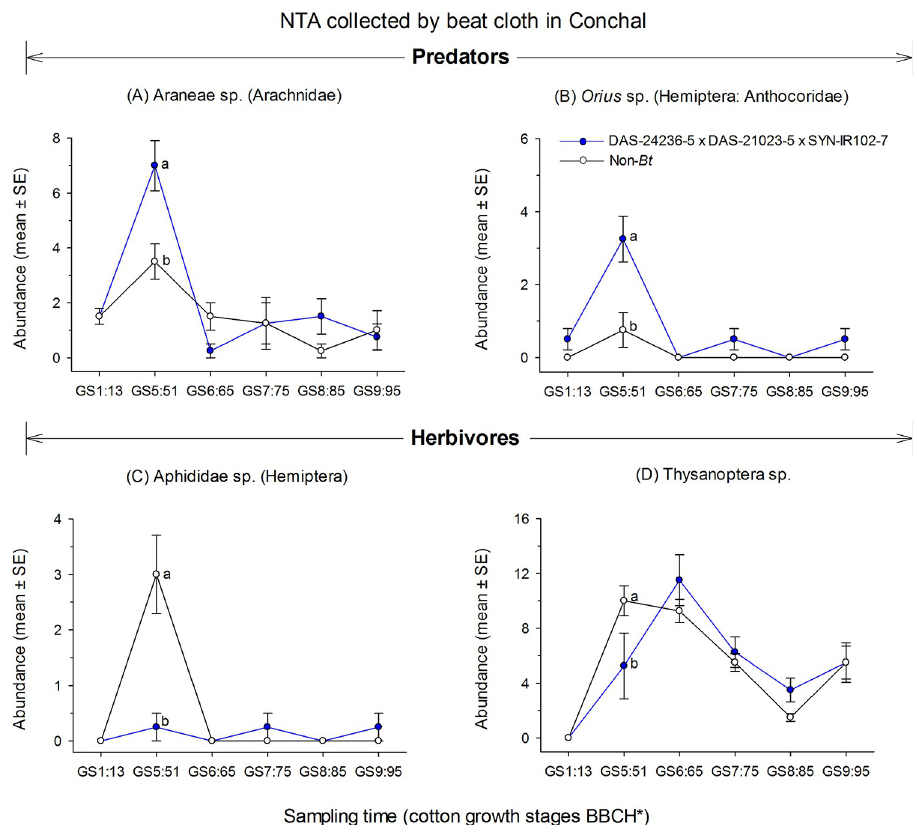
Fig 5. Abundance of foliar-dwelling arthropods collected via beat cloth method in a cotton trial at Conchal (2014/ 2015 cropping season). Means ( ± SE) within sampling time followed by different letters are significantly different by two-way RM-ANOVA test ( α = 0.05). � Phenological growth stages of cotton classified according to Munger et al. (1998).